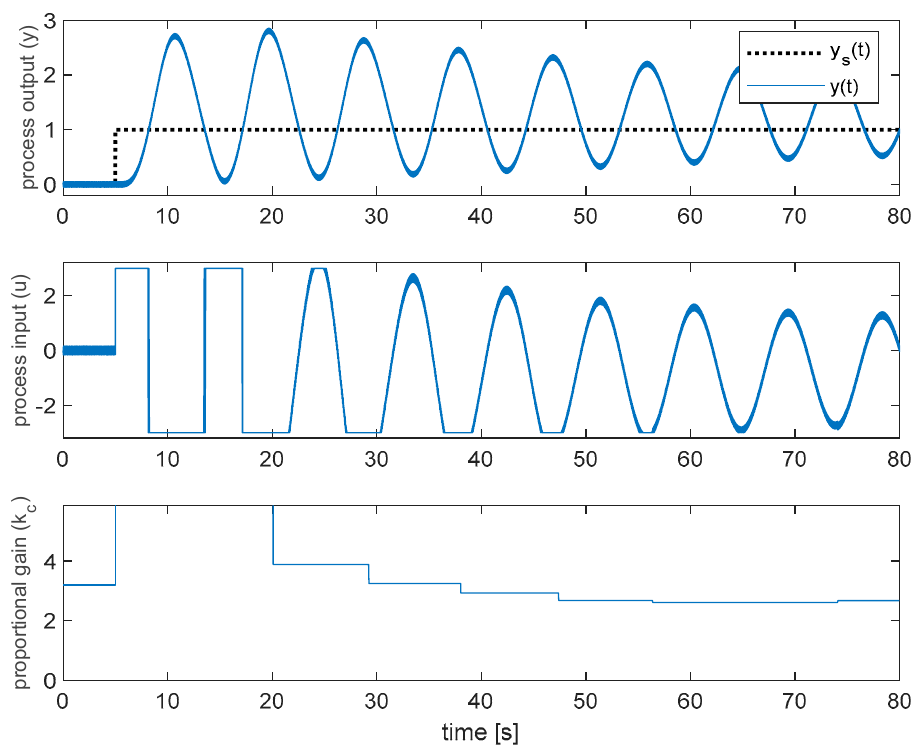
Figure 9. Response of the proposed method for the high-order plus time-delay process with θ = 0.1 and PA set = − π .